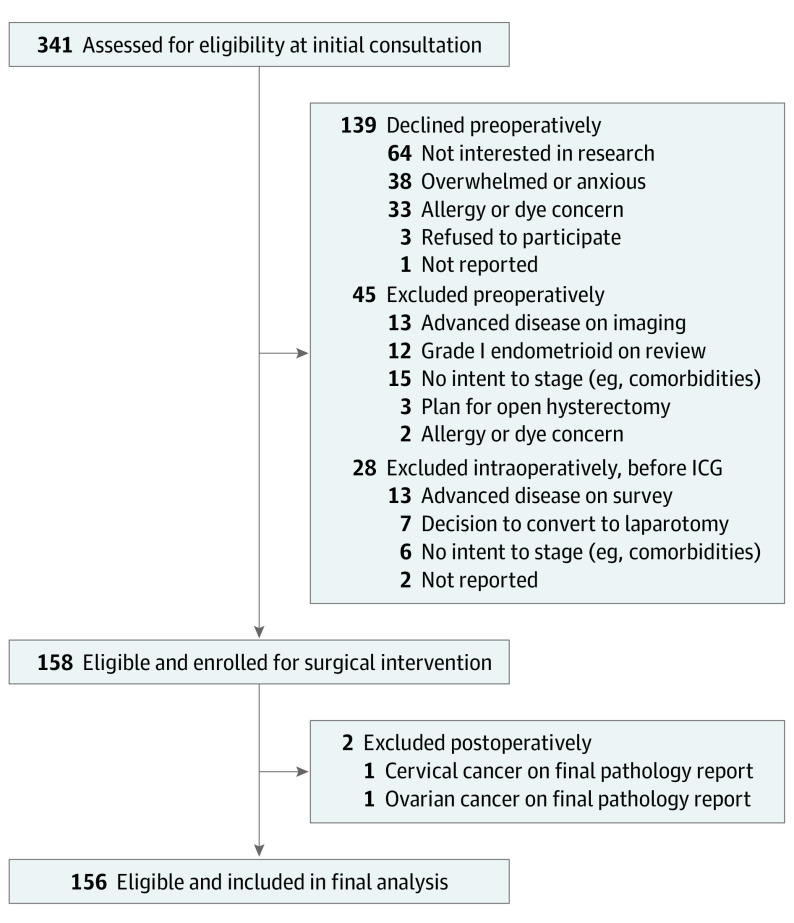
Flow Diagram of Included PatientsICG indicates indocyanine green.